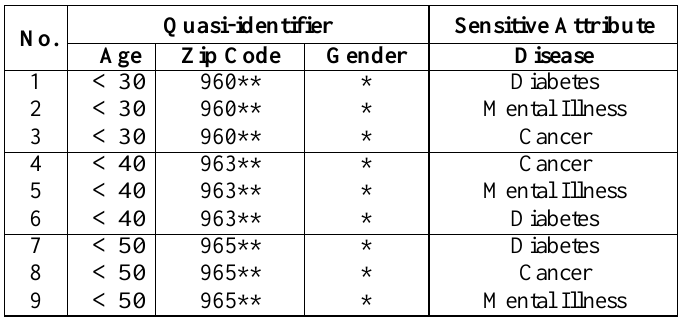
Table 3. Another published data of Table